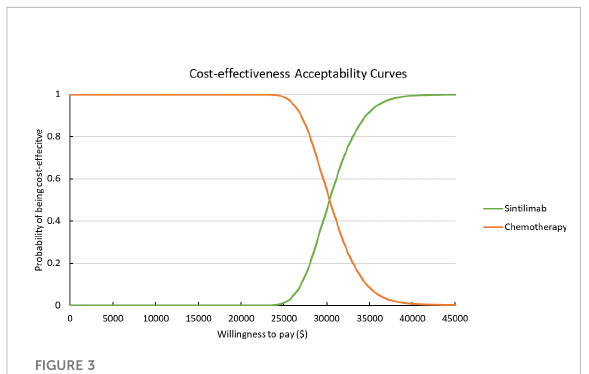
FIGURE 3 Cost-effectiveness Acceptability Curves. Green line represents the sintilimab group; orange line represents the chemotherapy group.